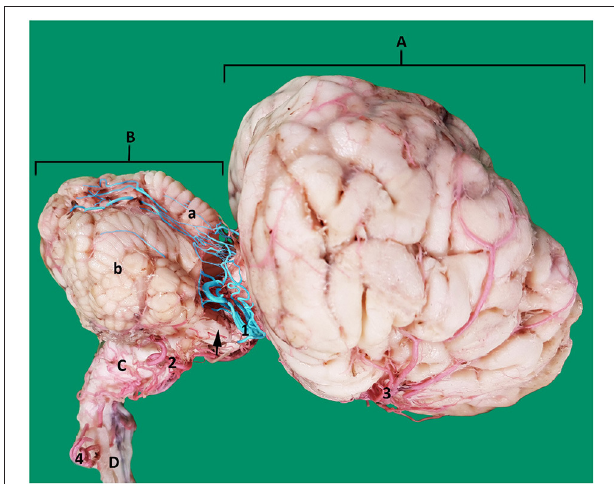
FIGURE 12 | Lateral view of an arterial cast of a dromedary brain. A, cerebrum; B, cerebellum where a, vermis and b, right cerebellar hemisphere; C, medulla oblongata; D, spinal cord; 1, rostral cerebellar artery; 2, caudal cerebellar artery; 3, middle cerebral artery; 4, vertebral artery. Note how the rostral cerebellar artery (highlighted in blue) (1) crosses the root of the trigeminal nerve (arrowed) and cerebral peduncle before moving toward the groove between vermis and cerebellar hemisphere on the rostral surface of the